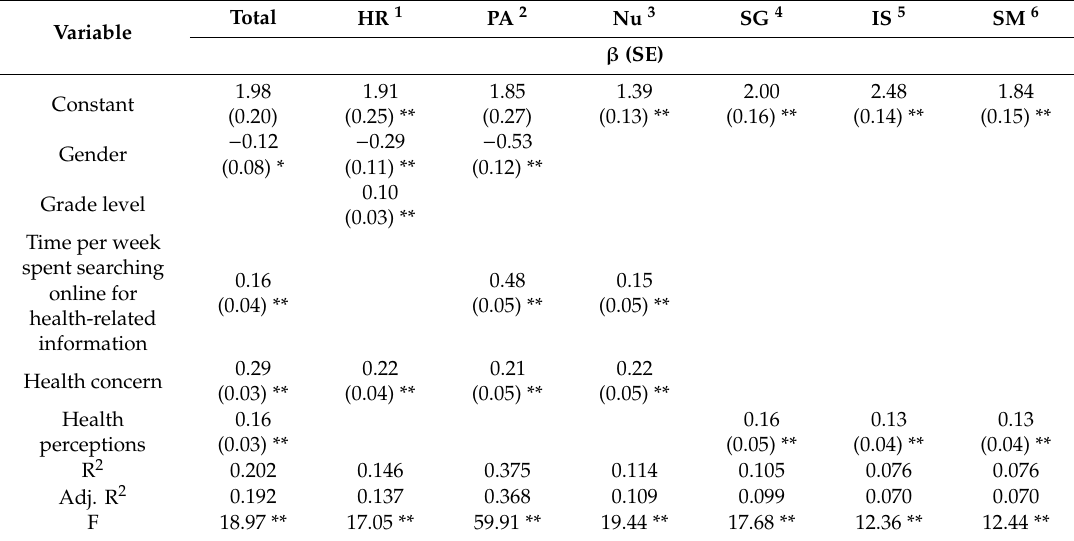
Table 4. Factors a ff ecting health-promoting behaviors (N =